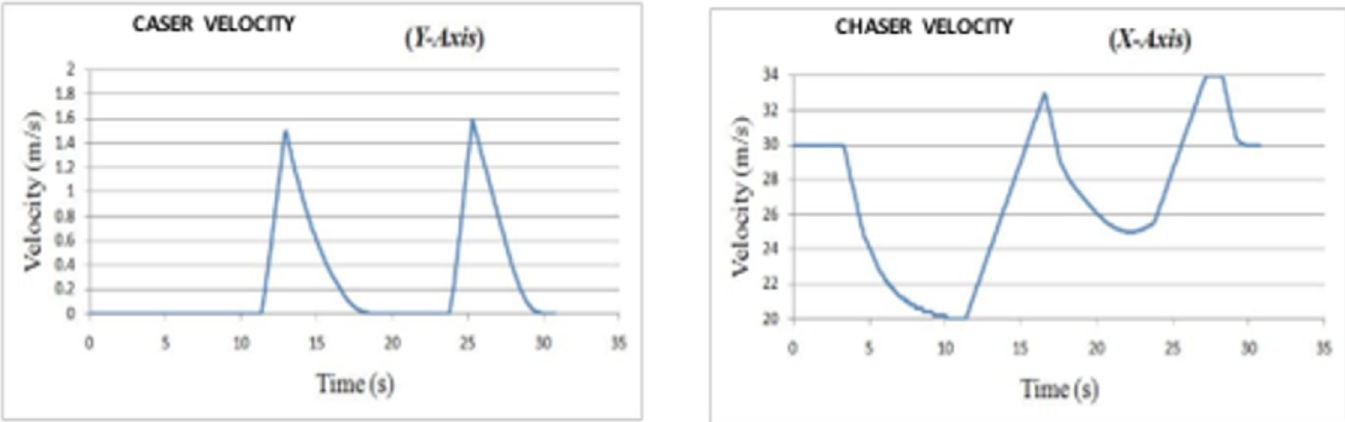
Fig 11. Lateral and axial velocities of C in scenario 2.